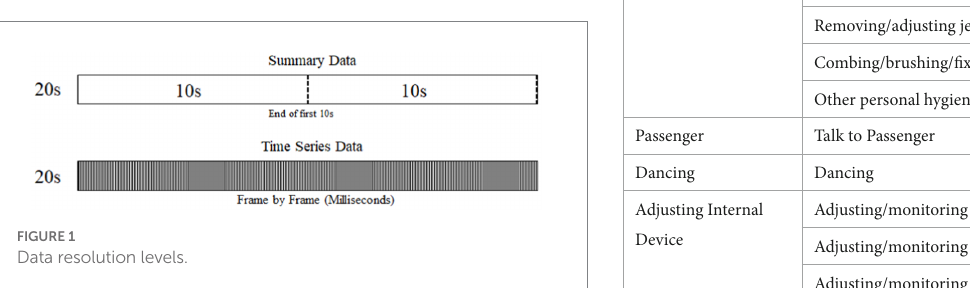
FIGURE 1 Data resolution